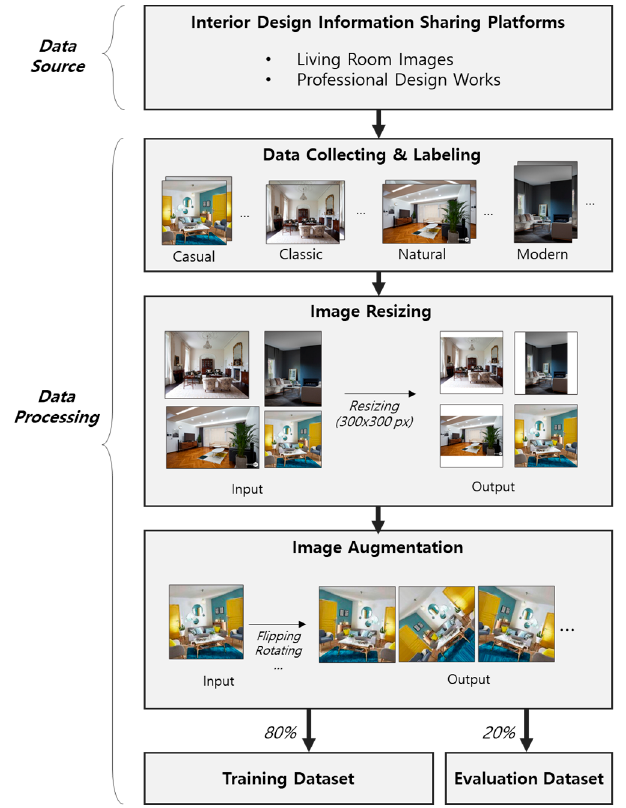
Figure 4. Flow diagram of data preparation for training and evaluation of the interior design style recognition model.